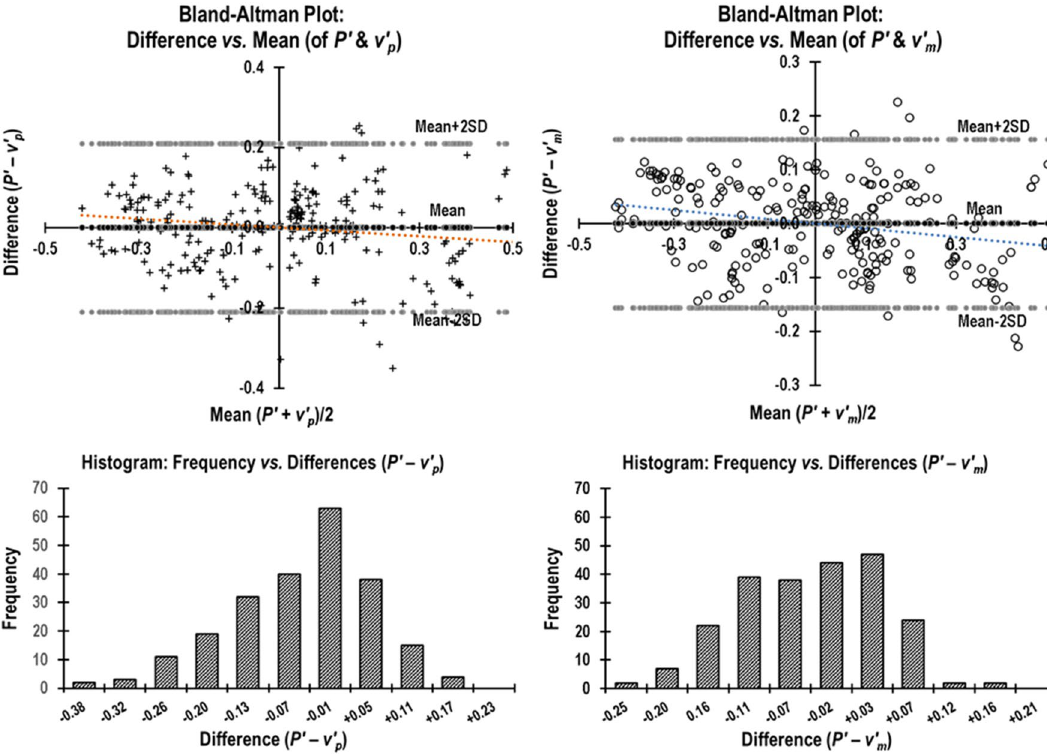
Figure 5. ( A ) Normalized Bland–Altman plot of the agreement between + dP/dt max ( P ′ ) and peak aortic velocity ( v p ). Plot of Difference ( P ′ – v p ) versus Mean ½( P ′ + v p ) along with the histogram distribution of the differences. ( B ) Normalized Bland–Altman plot of the agreement between + dP/dt max ( P ′ ) and peak aortic velocity 2 /T ( v p 2 /T ). Plot of Difference ( P ′ – v p 2 /T ) versus Mean ½ ( P ′ + v p 2 /T ) along with the histogram distribution of the